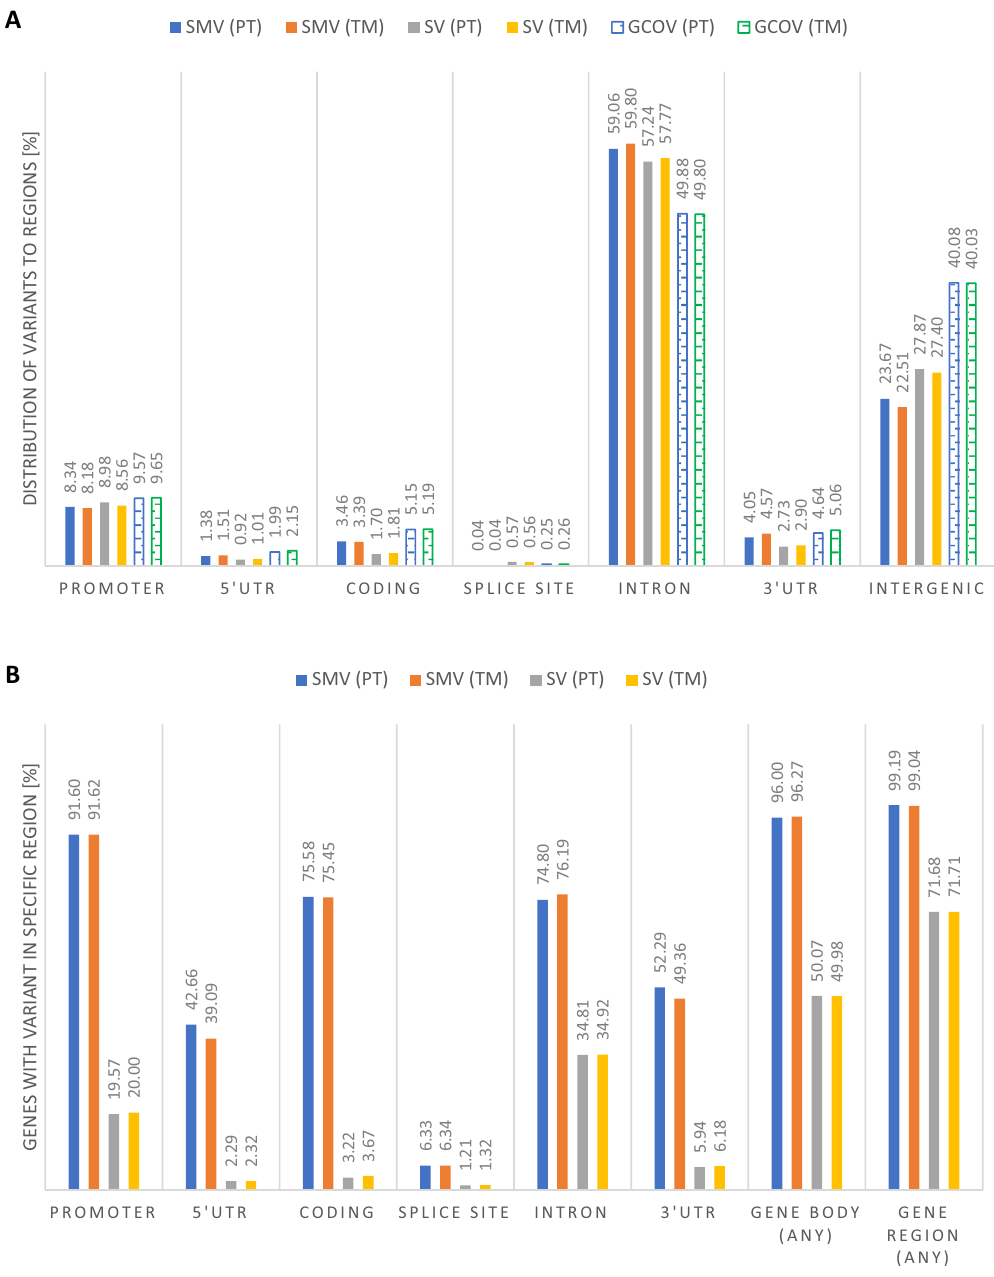
Figure 3. Variant location distribution and proportion of genes exhibiting a variant in a particular structural/ functional region. ( A ) With respect to structural/functional regions the distribution of called small and structural variants is typical—i.e., it largely follows the proportion of the respective genomic region with respect to the entire genome. Around 60% of variants are located in gene introns, followed by ~ 25% in intergenic regions and ~ 8.5% in gene promoters. ( B ) Under the applied parameters for calling and filtering almost all genes (~ 96%) are affected by some small variant and ~ 50% by some structural variant. Interestingly, the proportions of genes exhibiting a SMV in the promoter (~ 92%; defined as 2 kbp upstream and 200 bp downstream of the TSS) or coding regions (~ 75%) are very high. Gene regions are defined as the gene body plus 5 kbp up- and downstream. SMV, small variant; SV structural variant; GCOV, genome coverage of specific region; TSS, transcription start